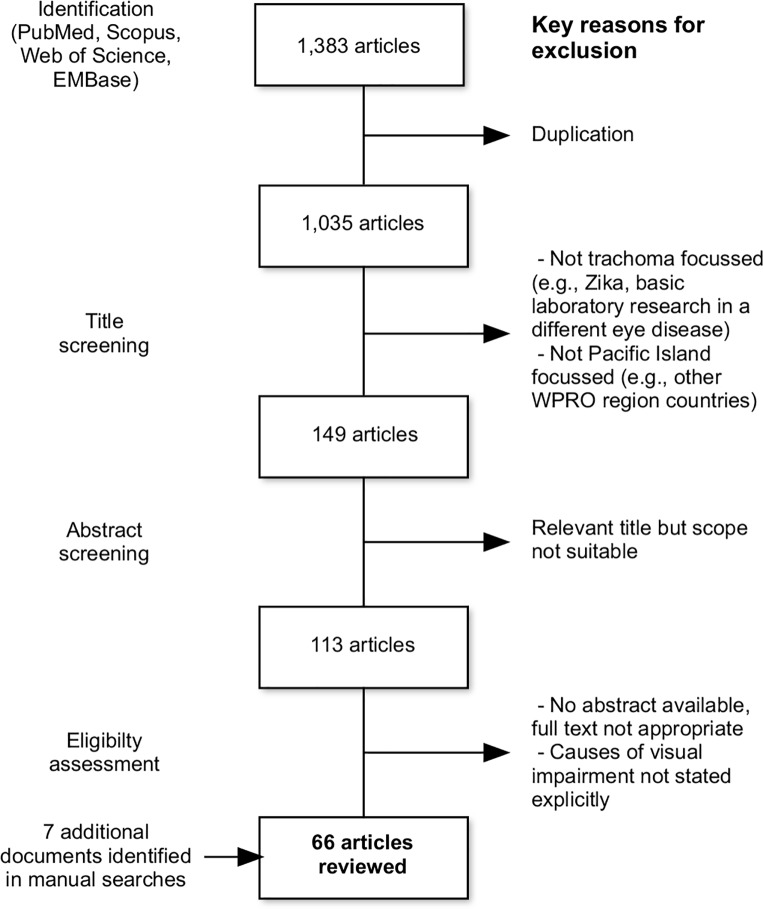
Flowchart of articles included in this systematic review and key reasons for exclusion at each stage.